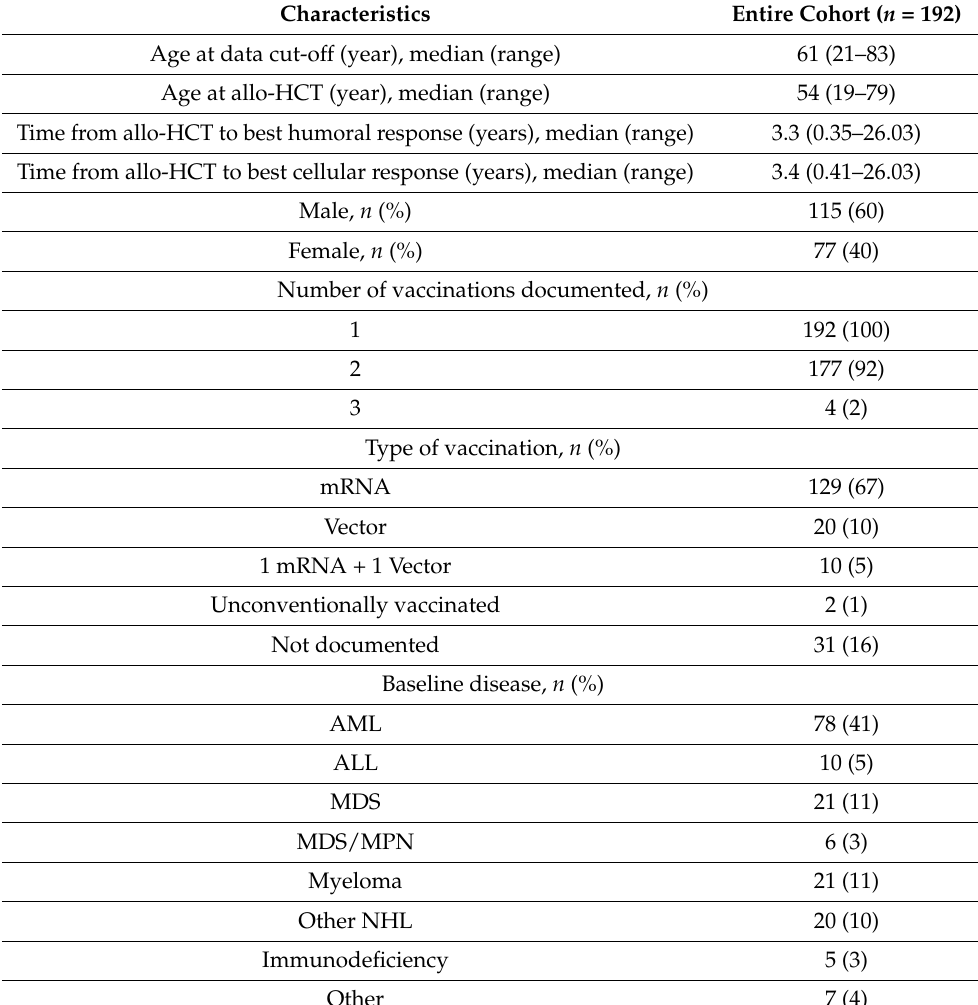
Table 1. Patient characteristics.